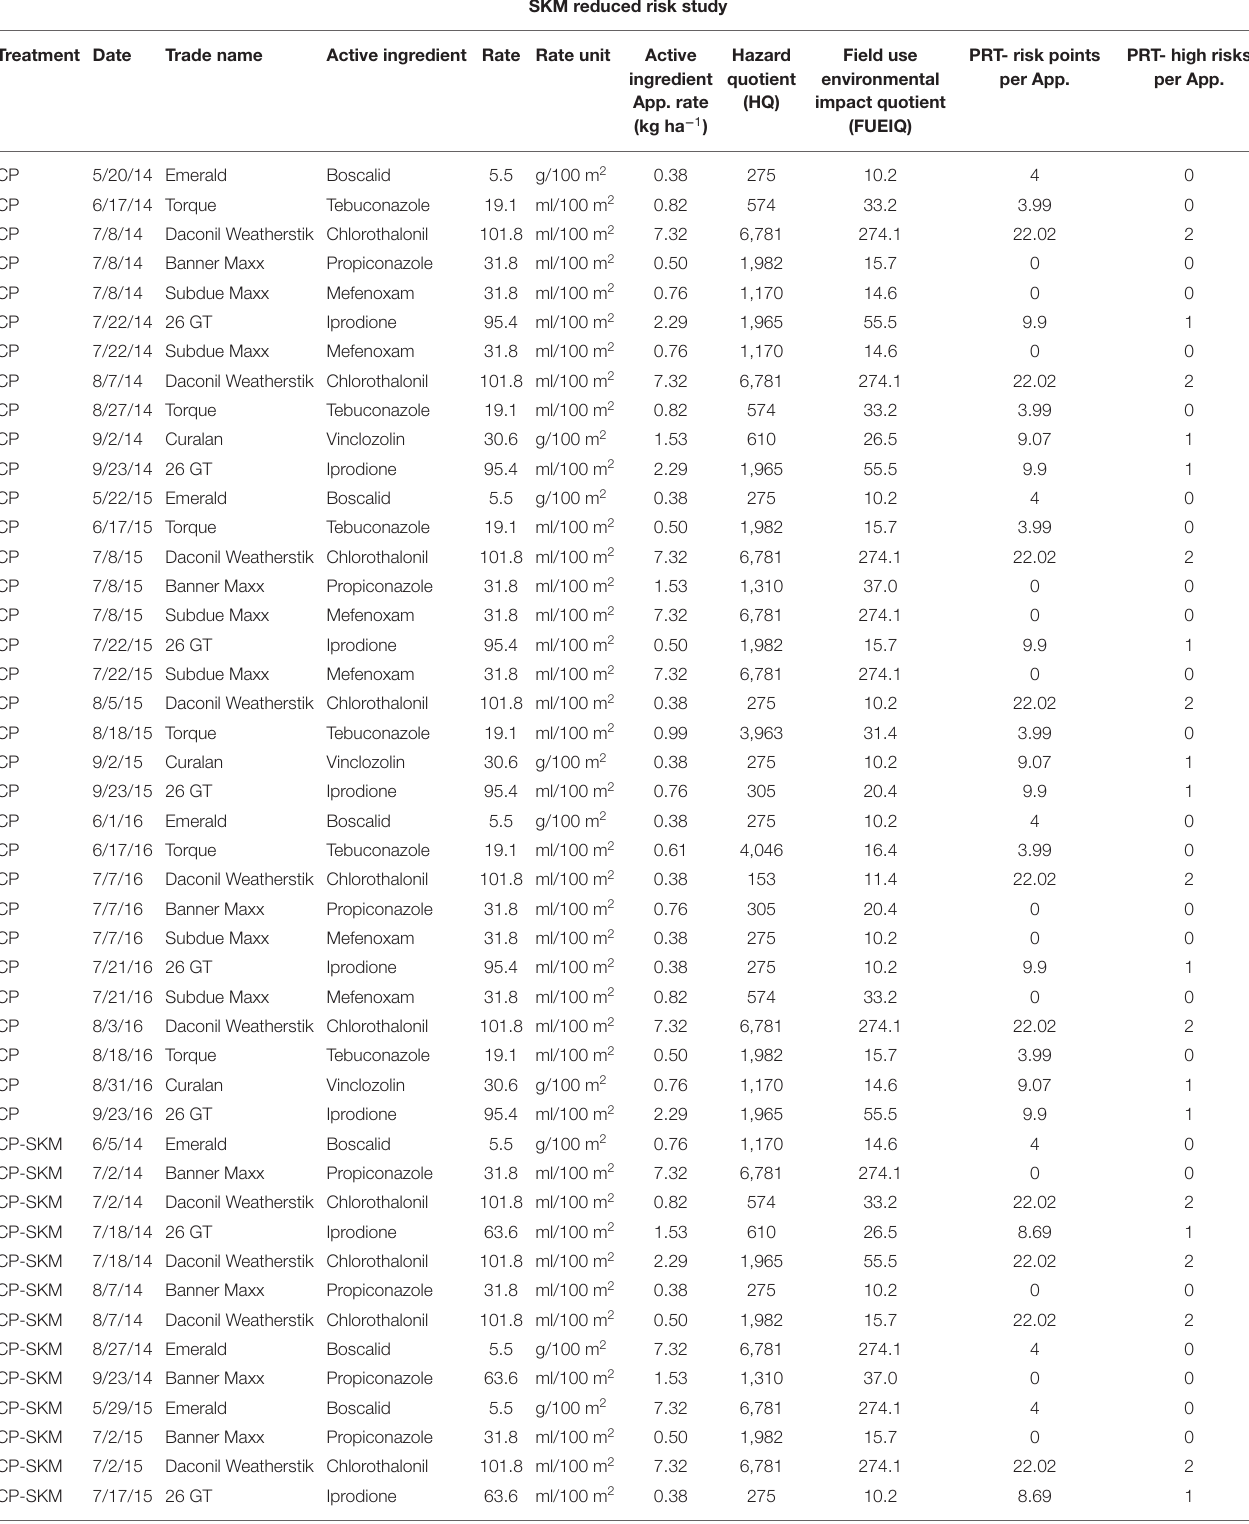
TABLE 2 | SKM reduced risk study treatment program, date, trade name, active ingredient, rate of application, and pesticide risk as quantified by active ingredient application rate, HQ, hazard quotient; EIQ, Environmental Impact Quotient; PRT, Pesticide Risk Tool for each product applied in the study. SKM reduced risk